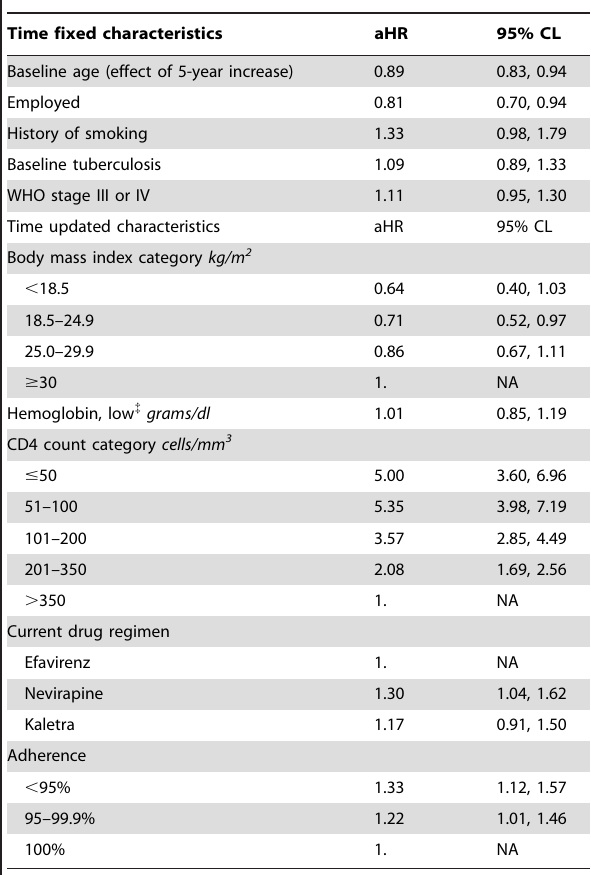
Table 3. Adjusted hazard ratios for non-causal associations of selected baseline and time-updated characteristics with time to virologic failure in 5,494 women initiating HAART in Johannesburg, South Africa from 1 April 2004 to